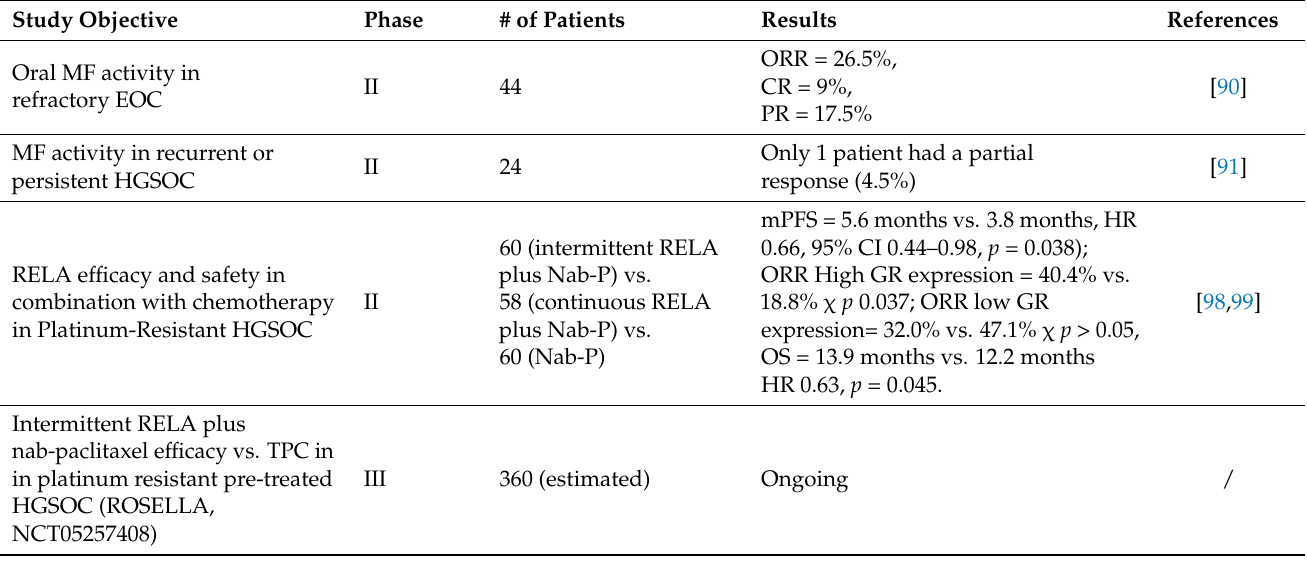
Table 2. Results from selected phase II/III trials of systemic treatment targeting